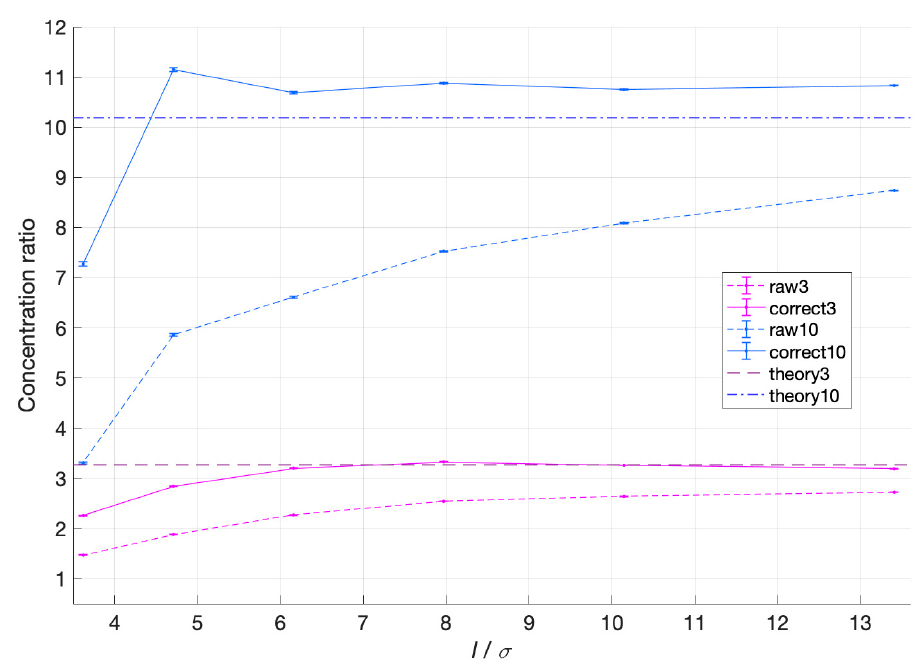
Figure 5. Comparison for concentration ratio for SBR = 10.18 in light blue and SBR = 3.27 in violet. For both acquisitions, acquisition time was fixed at 4 min and the reconstruction algorithm was with TOF correction. The dotted lines represent the raw images, while the continuous ones the PVE corrected images.